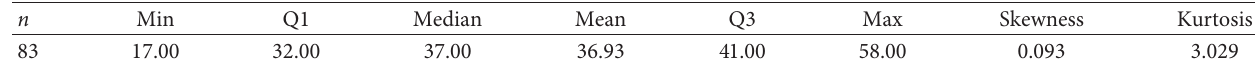
Figure 8: Graphical plots of the data and the PMF of the DEOWE distributions, where x is the number of deaths per day and p ( x ) is the probability for each x . Table 7: Descriptive statistics for the second